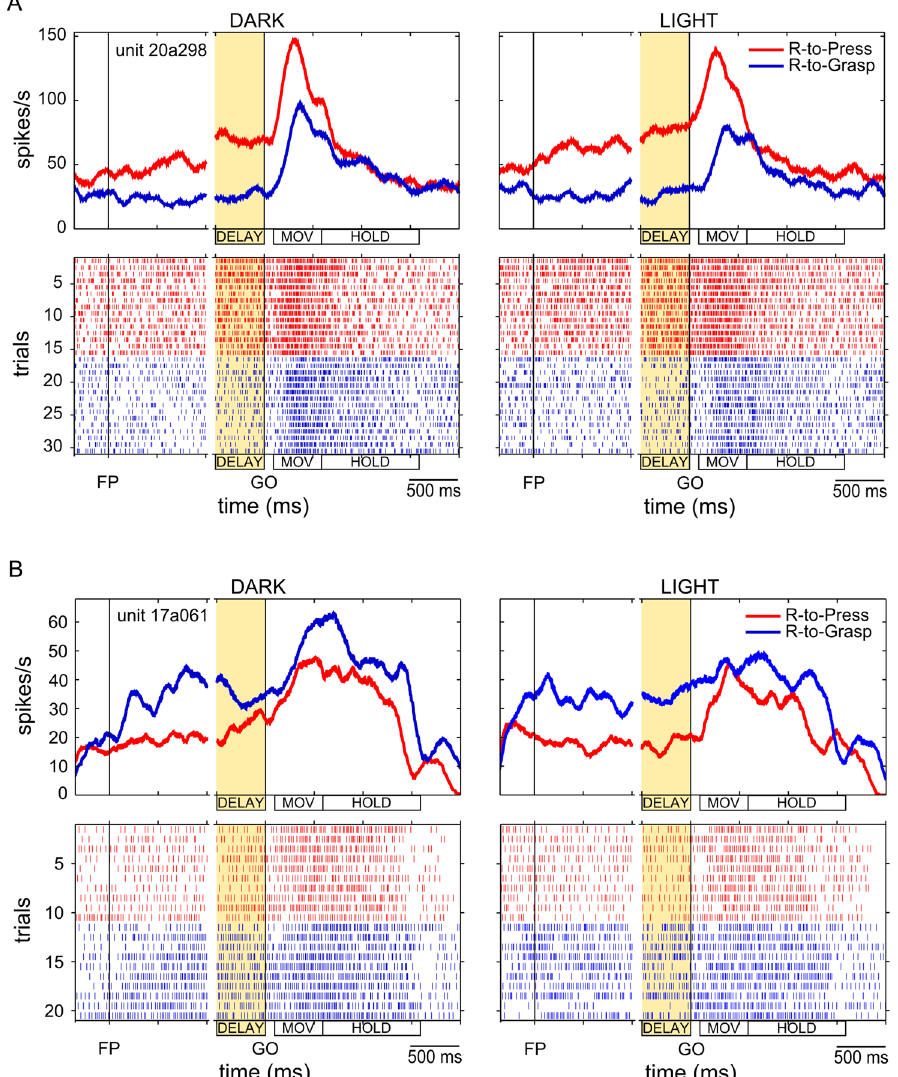
Figure 3. Examples of single neurons classified as Task cells . ( A ) Example of Task cell showing a preference for reach-to-press movements. Activity is shown separately for the Reach-to-Grasp Task (in blue; “R-to-Grasp”) and for the Reach-to-Press task (in red, “R-to-Press”), either when executed in a dark (left panels) or in a light background (right panels). Both SDFs (upper panels) and raster plots of impulse activity (lower panels) are shown for each experimental condition. Neural data from single trials were realigned twice, first to the onset of the fixation LED (FP, left vertical line) and then to the GO signal (GO, right vertical line). The yellow area on the graphs represents the time epoch of major interest for the purpose of the present study, i.e. the DELAY epoch, within which a significant modulation of activity by the factor Task was assessed for the depicted cell. Scale: vertical bar on SDFs, 153 spikes/s. ( B ) Example of Task cell showing a preference for reach-to-grasp movements. All conventions as in panel A. Scale: vertical bar on SDFs, 68